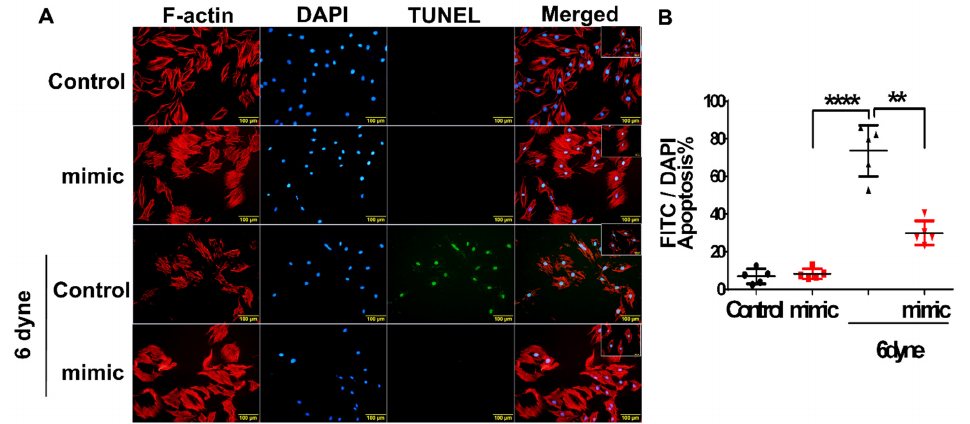
Figure 6. The over-expression of MiR-21 rescues flow shear stress-induced apoptosis in cardiomyocytes. The cardiomyocytes were transfected with miR-21 mimic for 24 h. Cell apoptosis as measured by terminal deoxynucleotidyl transferase-mediated dUTP nick end labeling (TUNEL). ( A ) TUNEL staining (green) indicated cardiomyocytes apoptosis and DAPI staining (blue) indicated